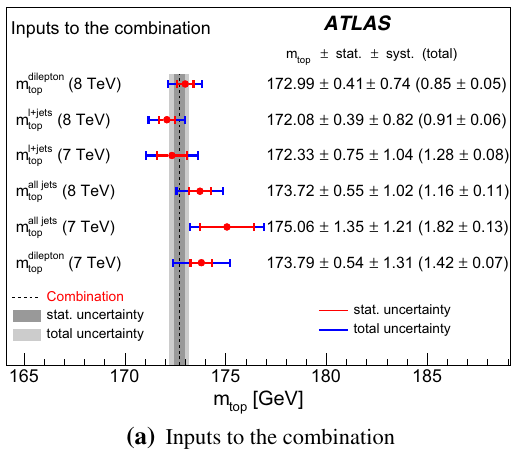
Fig. 10 The combination of the six ATLAS results of m top accord- ing to importance Ref. [98]. a shows the inputs to the combination. b shows results of the combination when successively adding results to the most precise one. The values quoted are the combined value, the sta- tistical uncertainty, the systematic uncertainty, the total uncertainty and